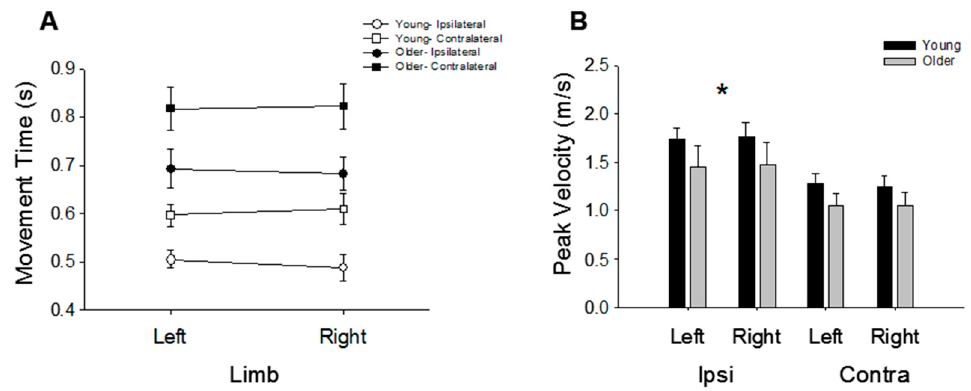
Figure 2. Movement time and movement speed. ( A ) Movement time was greater for older adults ( p < 0.001) and contralateral movements ( p < 0.001). There were no differences between the right and left hands. ( B ) Peak velocity was similar between hands for the ipsilateral and contralateral movements and for the young and older adults. However, the contralateral movements were characterized by a lower peak velocity compared with the ipsilateral movements (* p < 0.001).